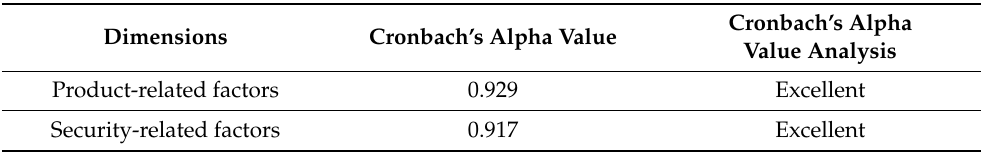
Table 6. Internal consistency of dimensions.